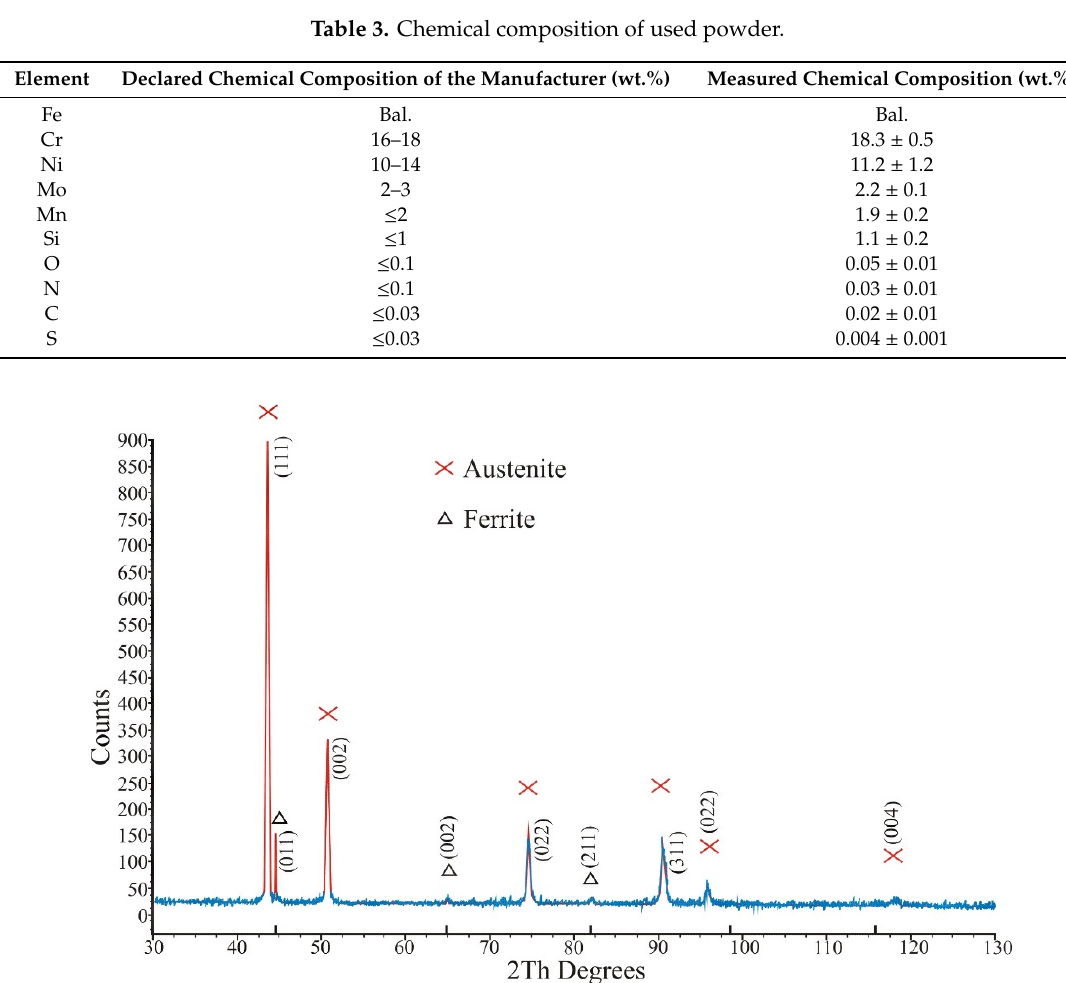
Figure 7. X-ray di ff raction patterns of the used Figure 7. X-ray diffraction patterns of the used powder. Table 3. Chemical composition of used powder.